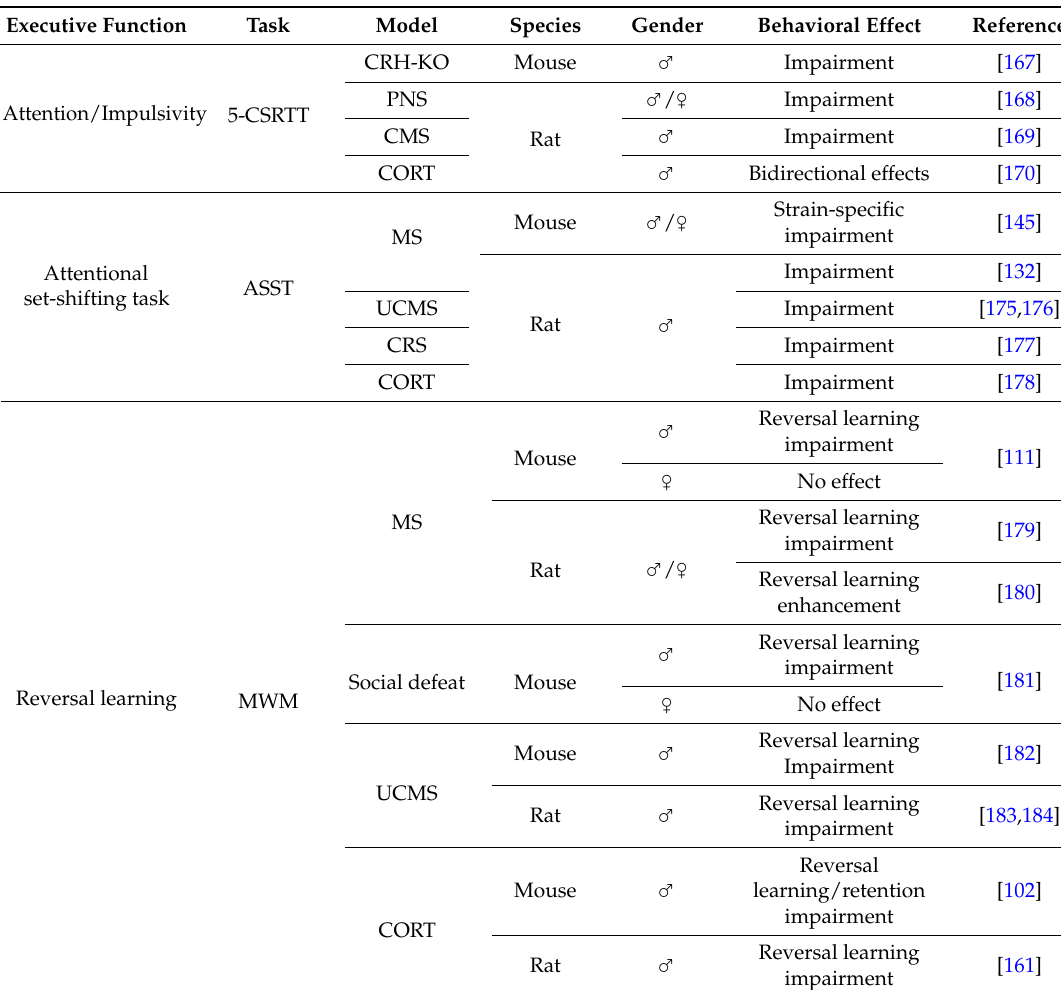
Table 5. Attention and executive functions performances in different rodent models of